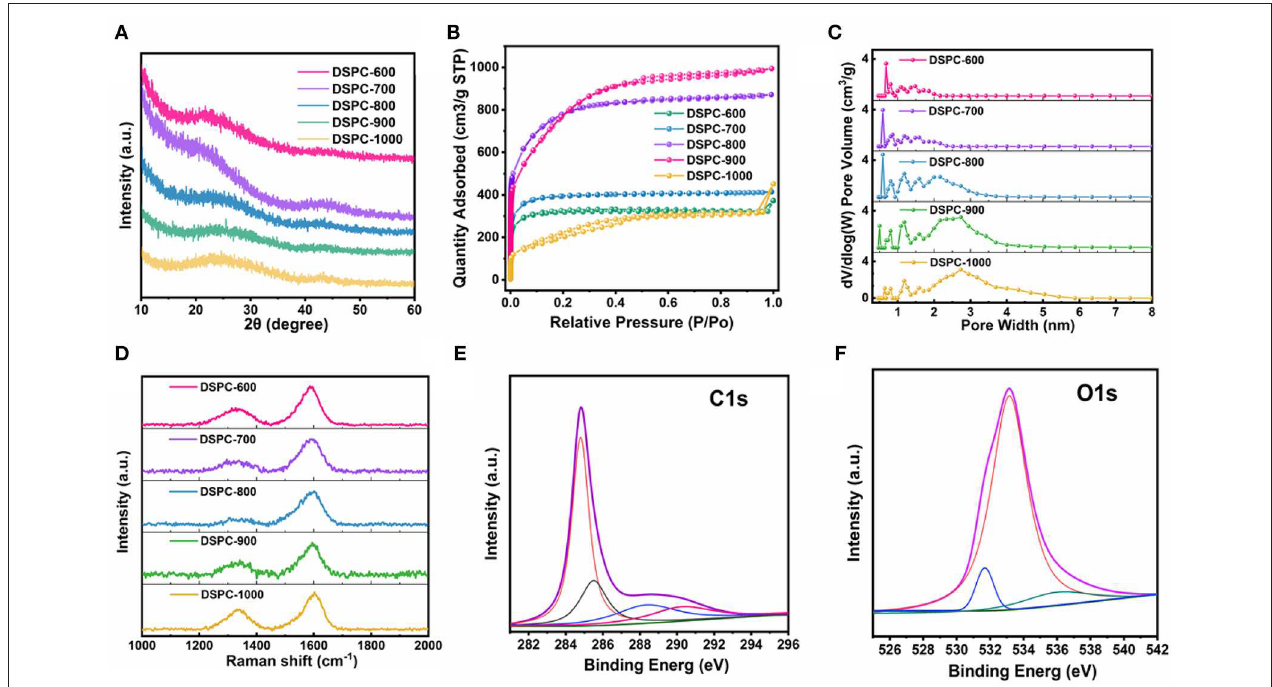
FIGURE 2 | (A) XRD patterns, (B) N 2 adsorption-desorption isotherms, (C) Pore size distribution, and (D) Raman spectrum of DSPCs. (E,F) high-resolution XPS C1s and O1s spectra for DSPC-800.